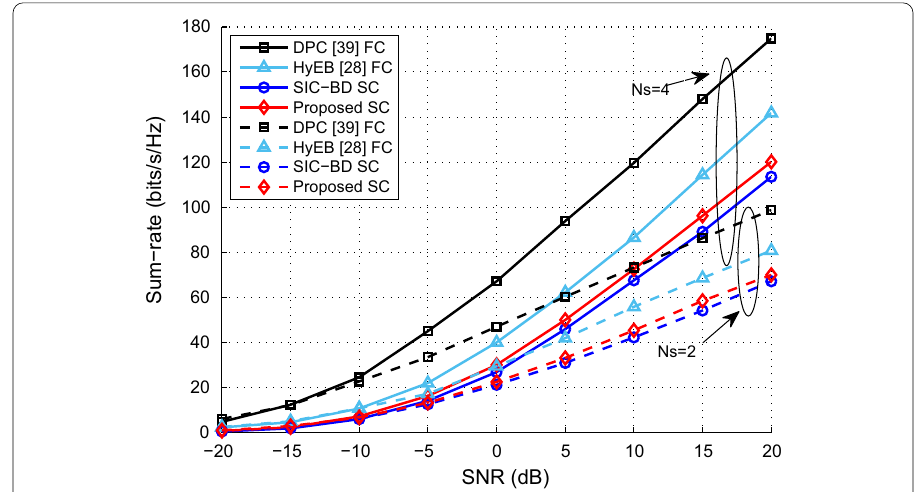
Fig. 7 Sum rate comparison for hybrid precoding schemes versus N s . The dotted line indicates sum rate when the number of data streams per user is N s = 2 . The solid line expresses sum rate when the number of data streams per user is N s =